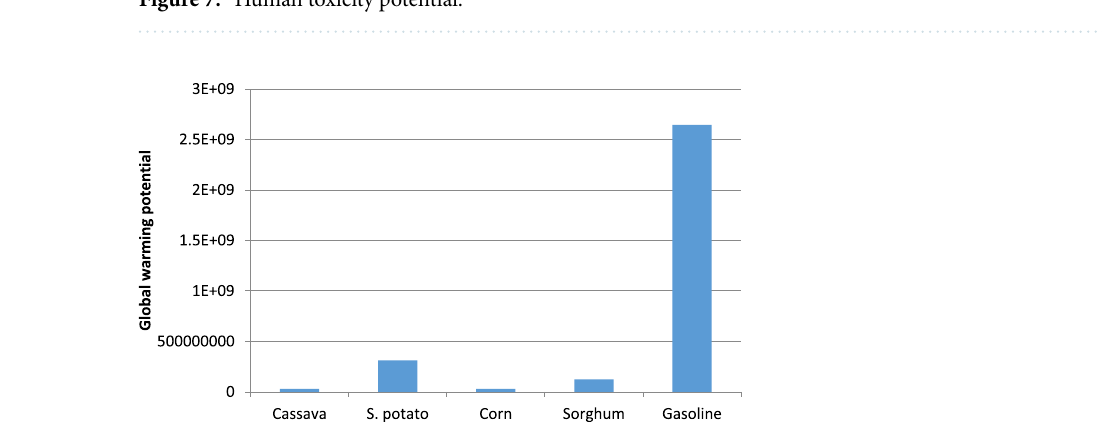
Figure 7. Human toxicity potential.